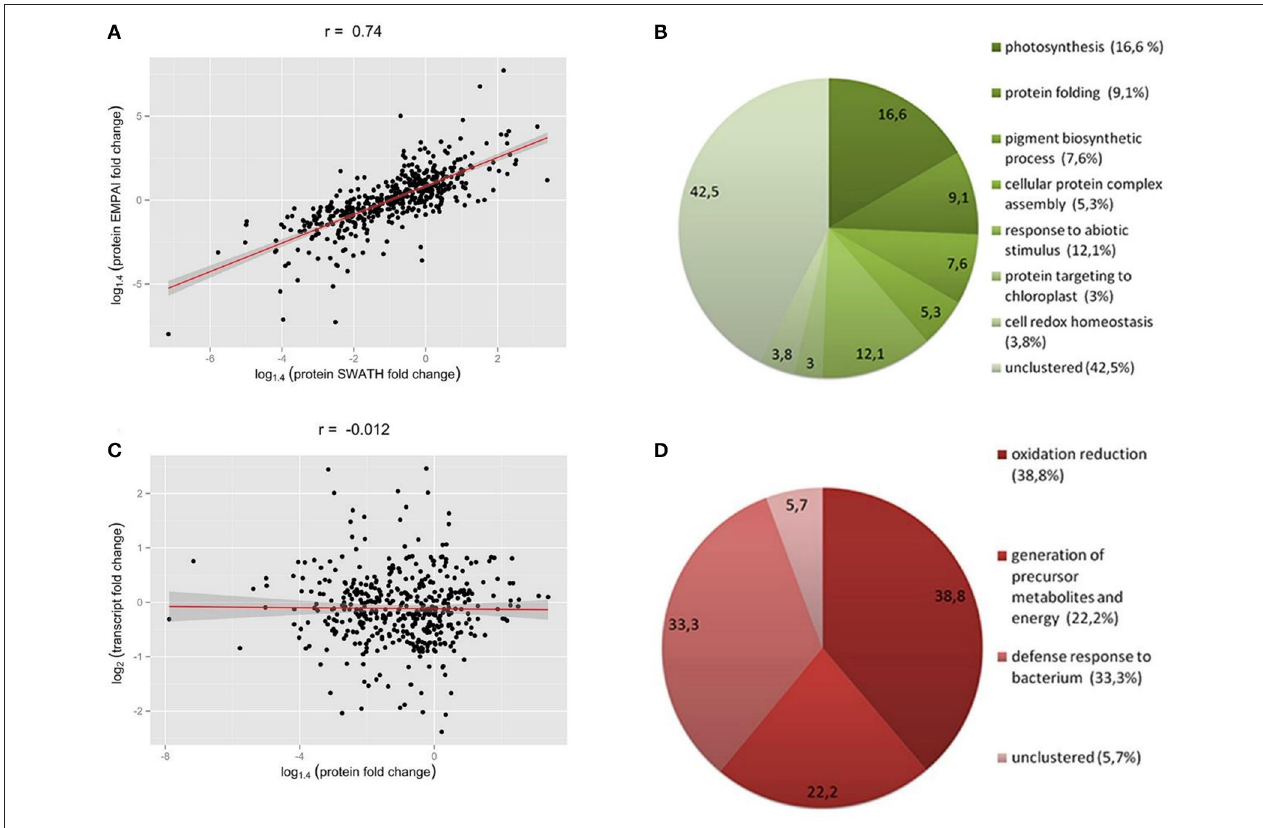
FIGURE 2 | (A) Correlation between SWATH- and emPAI-derived protein fold change (A) , r, Pearson correlation coefficient. (B,D) Functional annotation of differentially accumulated proteins (DAPs) in chloroplasts of protoplasts compared to protonemal tissue. GO biological process terms for down-regulated proteins in protoplasts (B) and up-regulated proteins (D) . Figures in brackets and on the diagram indicate % of all clusterized genes by topGO (132 down-regulated proteins and 18 up-regulated proteins). (C) SWATH-derived protein fold change and transcript FPKM-derived fold change for corresponding genes.